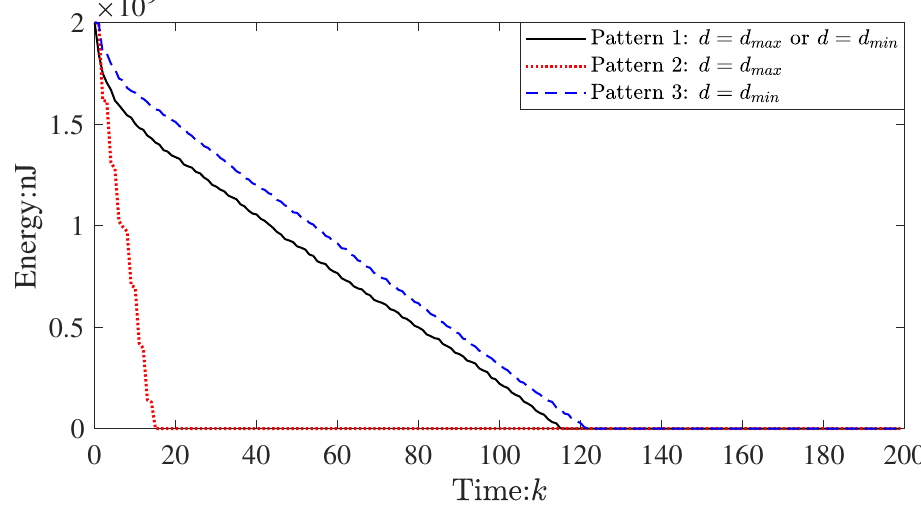
Figure 7. The energy consumption change of the node that first runs out of energy in three patterns when δ =